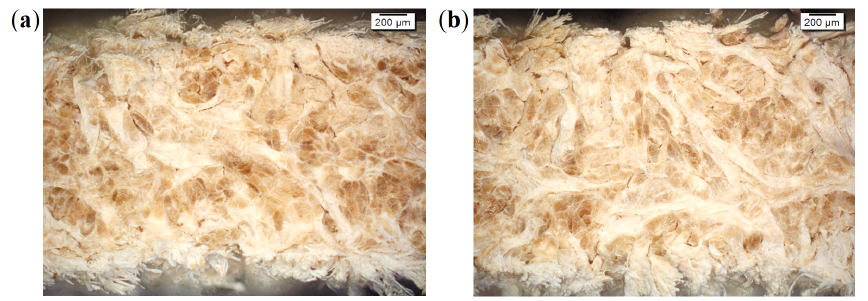
Figure 1. Light microscopic images of split leather samples from back parts: ( a ) Simmental breed leather L1 and ( b ) zebu breed leather L3.